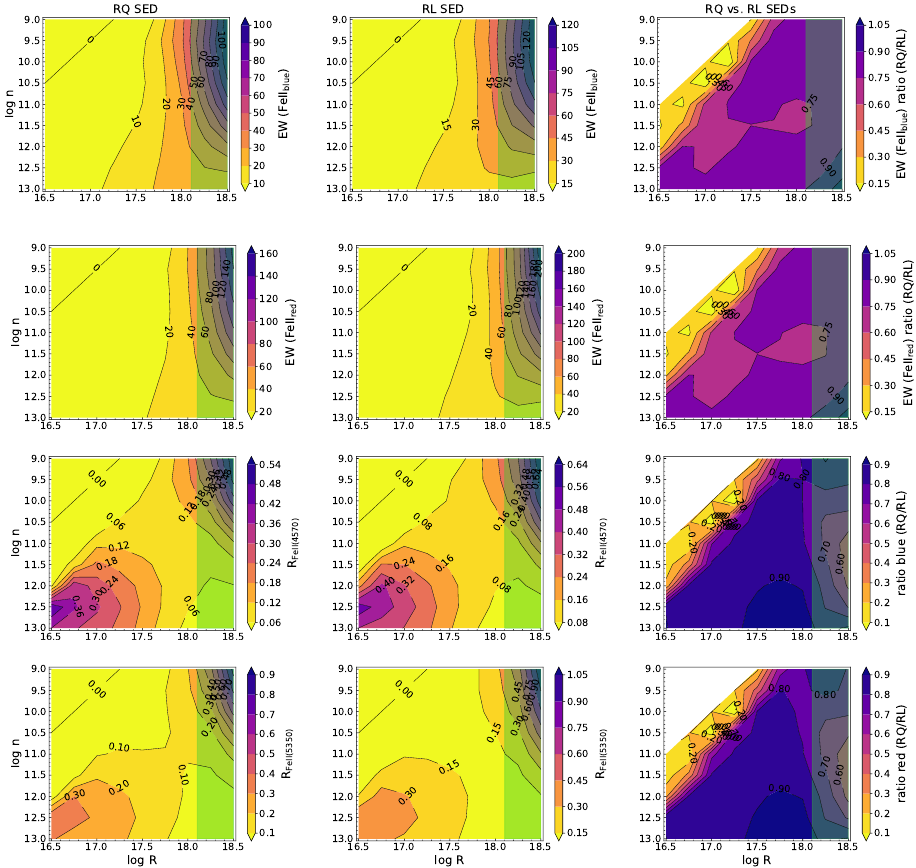
Figure 10. Results of CLOUDY simulations. First two rows: W(Fe II λ 4570) for RQ and RL (i.e., computed for the same physical parameters but with the two different SEDs of Laor et al. [88]) and their ratios; third and fourth row from top: R FeII , for RQ and RL and their ratios. Last four rows: same, for the red (R) Fe II blend peaked at λ 5312 Å.